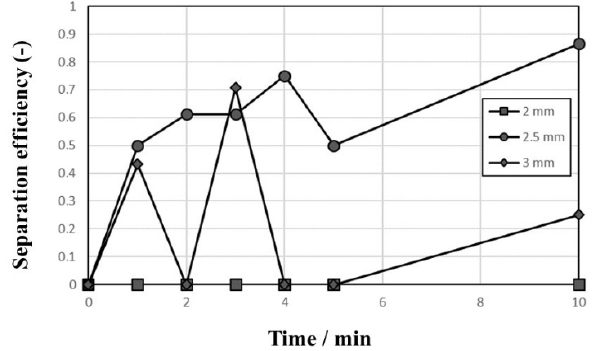
Figure 6. Separation efficiency of Al and STS scraps using a 2-mm zirconia ball medium with vibration amplitudes of 2, 2.5, and 3 mm.